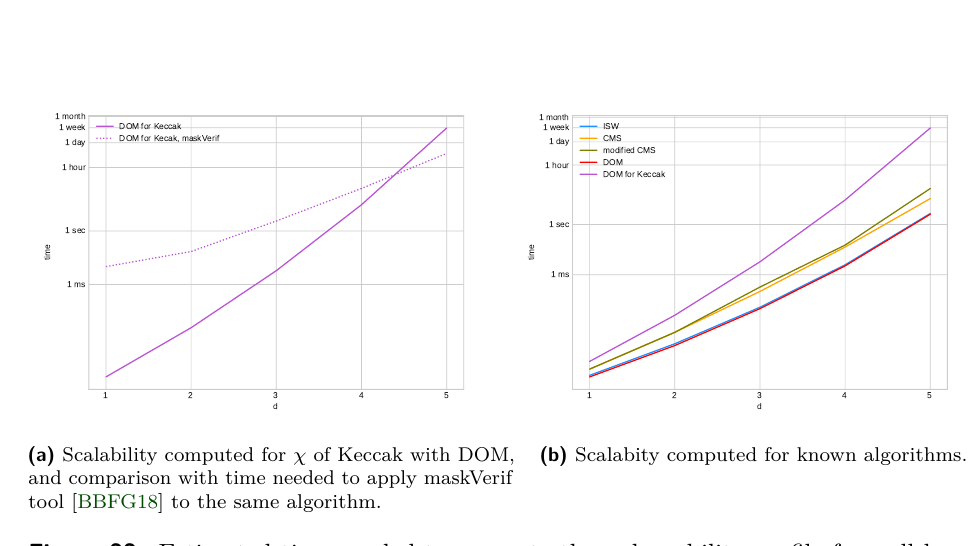
Figure 22: Estimated time needed to compute the vulnerability profile for well known